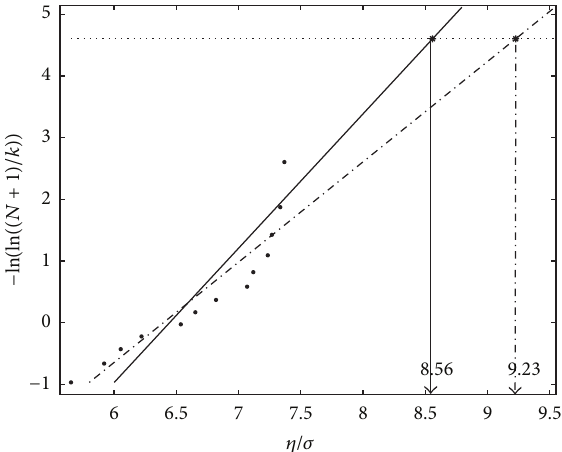
Figure 6: Nordøyan wind speed statistics, 13 years hourly data. ̂𝜀 1 (𝜂) ( ∗ ); optimized curve fit (—); empirical 95% confidence band (--); optimized confidence band ( ⋅⋅⋅ ). Tail marker 𝜂 1 = 12.5 m / s = 2.08𝜎 ( 𝜎 = 6.01 m / s).